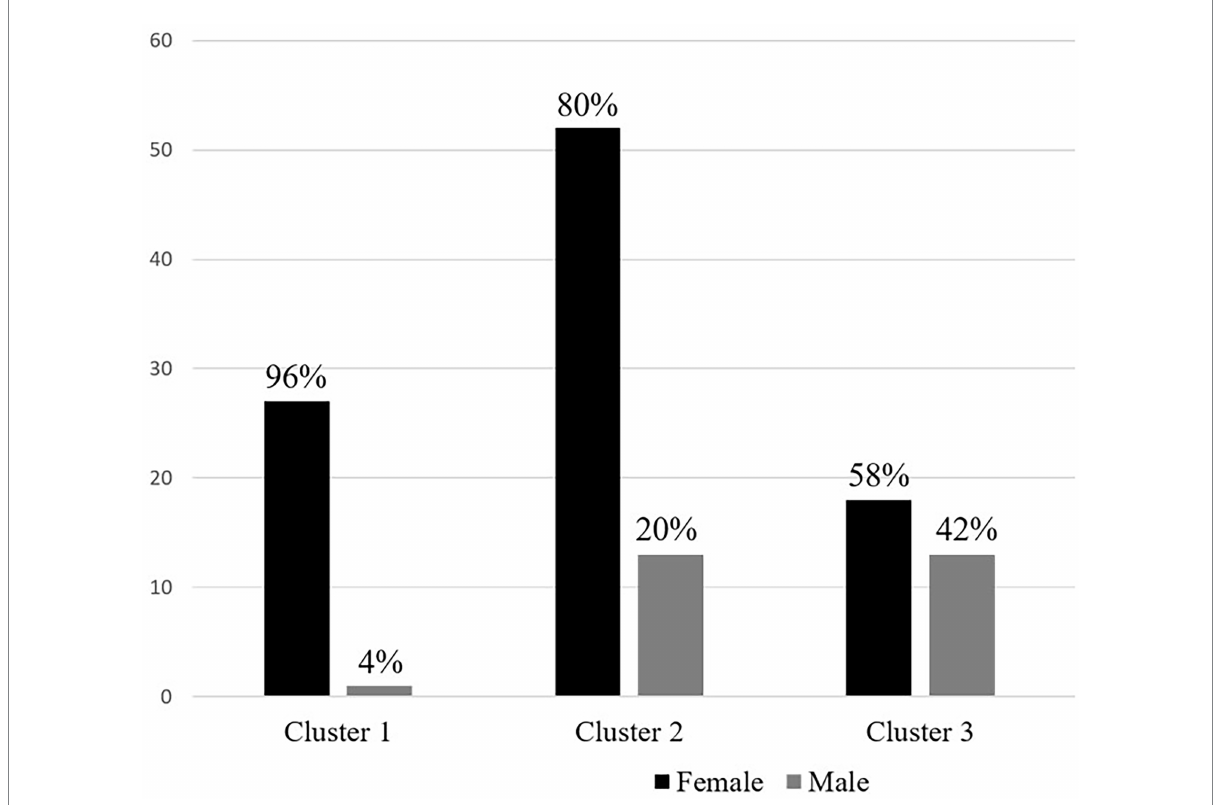
FIGURE 2 Distribution of teachers over the different technology readiness